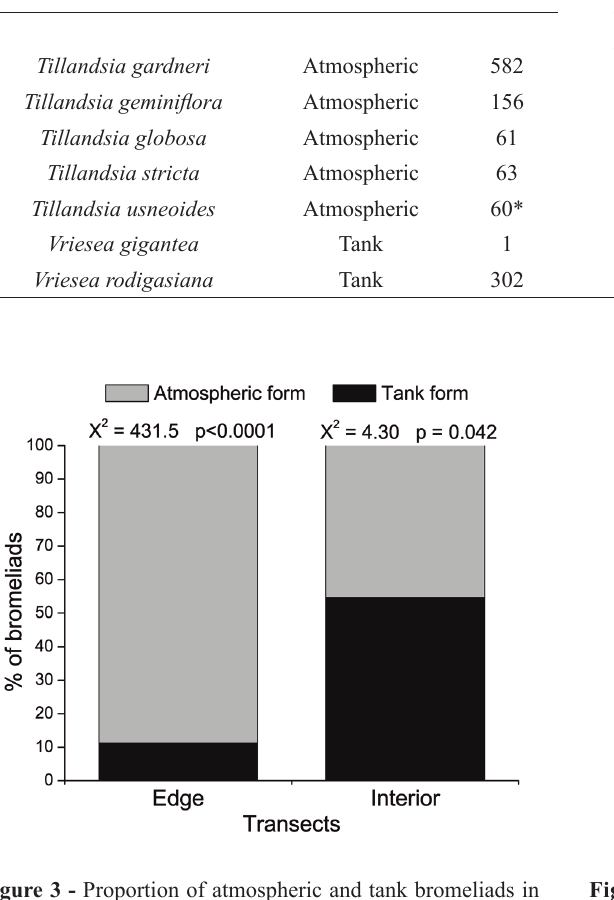
Figure 3 - Proportion of atmospheric and tank bromeliads in the edge and interior transects of Itapanhaú mangrove. Chi- square